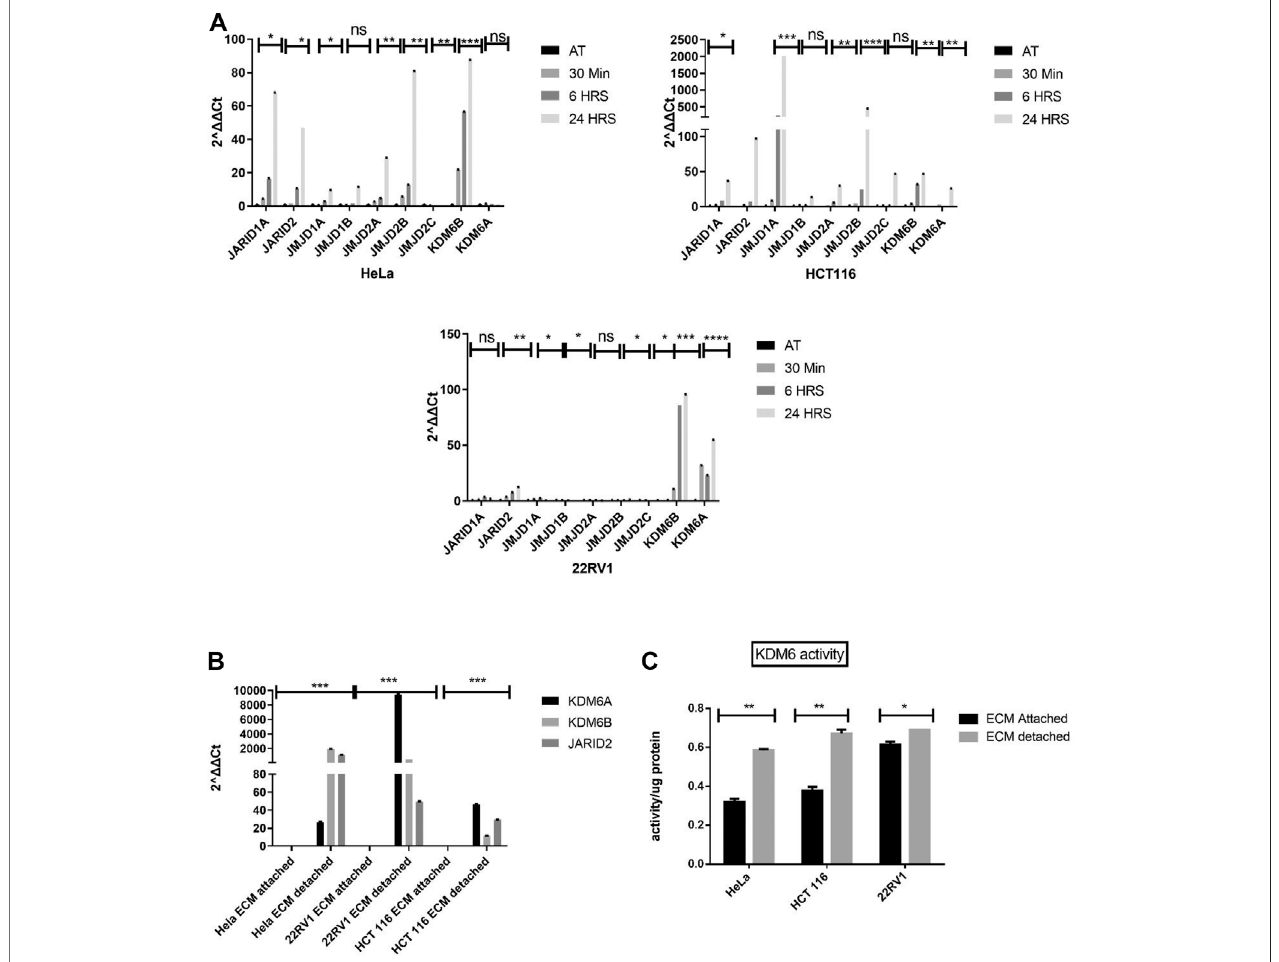
FIGURE 1 | Matrix detachment induces the KDM6B expression and activity. (A) Expression of various hypoxia-regulated histone demethylases in HeLa, HCT116, and 22Rv1 cell lines during matrix detachment at shorter time points (30 min, 6, and 24 h). (B) JARID2 and KDM6B/A in HeLa, HCT116, and 22R ʋ 1 cell lines during matrix detachment for six days. The values were normalized with the housekeeping gene RPLP0 , and other gene expression values were calculated. (C) KDM6 demethylase activity was measured in the nuclear extract of HeLa, HCT116, and 22Rv1 cells grown in matrix-detached conditions. ** p .value > 0.001, * p .value > 0.01, *** p .value >